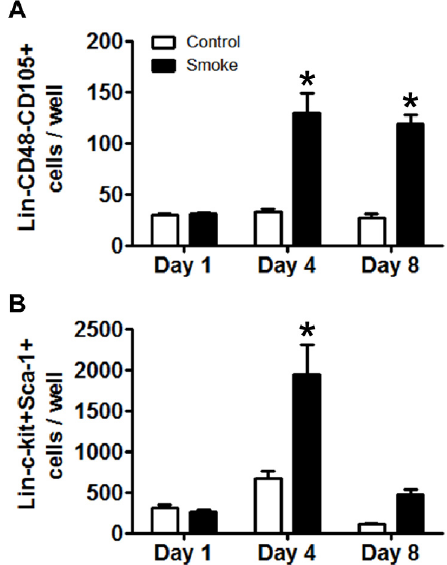
Figure 4. Co-culture of Lin-GFP+ HSPCs with MSCs isolated from control and smoke-exposed animals. ( A ) MSCs isolated from smoke-exposed animals leads to increased numbers of Lin-GFP+CD48-CD150+ cells following 4 and 8 days of co-culture; ( B ) Lin-c-kit+Sca-1+ ST-HSCs are increased after 4 days of co-culture in the smoke-exposed MSC group, but return to day 1 levels after 8 days. * p < 0.05; N = 5 for each